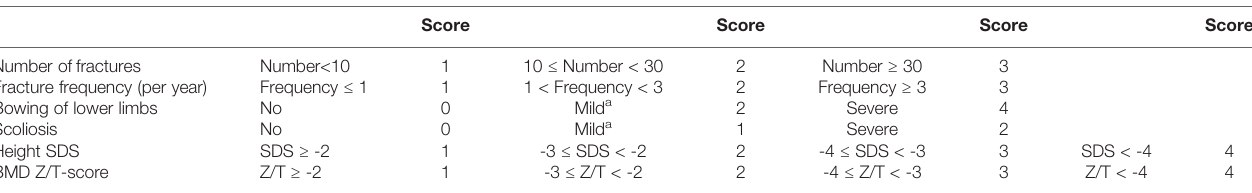
TABLE 1 | The proposed clinical scoring system for osteogenesis imperfecta patients.